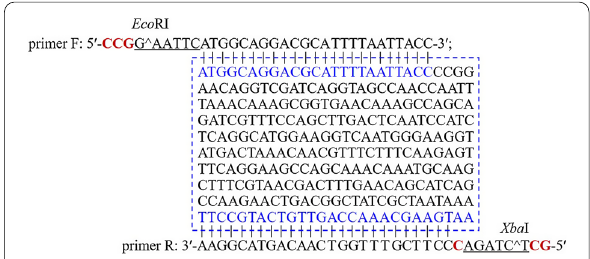
Fig. 1 Informationsof esxA and primers Full length of esxA (in squre frame), primers with recognized bases and restriction sites of Eco RI and Xba I as well asprotective bases (bold in red letters) are